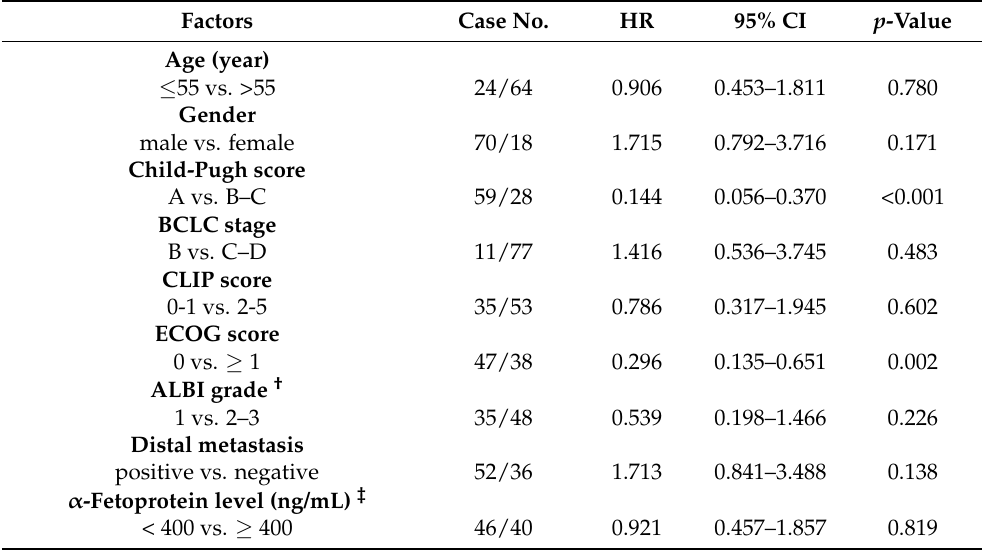
Table 3. The multivariate Cox regression analysis of factors predicting overall survival. Factors Case